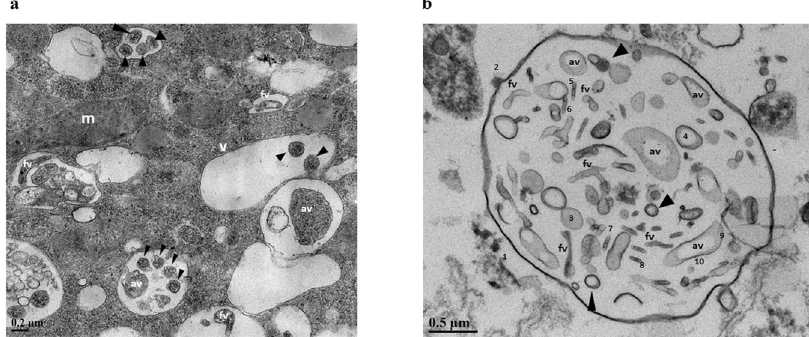
Fig. 2 Ultrastructural visualisation of internalised RSV. a Transmission electron microscopy of RSV particles within W. magna food vacuoles after 72 h of co-culture. b Puri fi ed released extracellular vesicle after 24 h of co-culture containing RSV virions. Virions were randomly selected and measured using ImageJ (marked 3 – 10). Three morphology categories of RSV were found: spherical (black arrowheads), asymmetric (marked av), and fi lamentous (marked fv). mitochondria (m), vacuole (v).